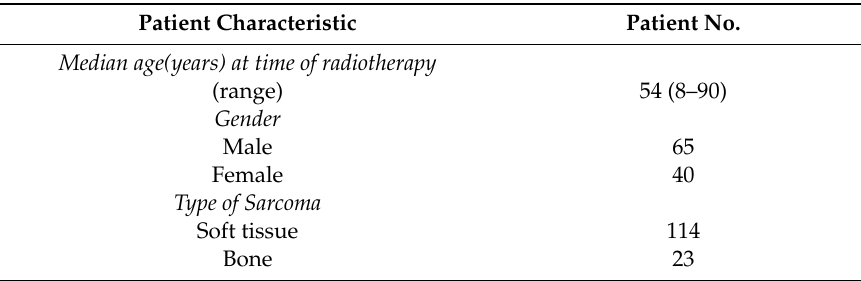
Table 1. Patient and tumour characteristics.